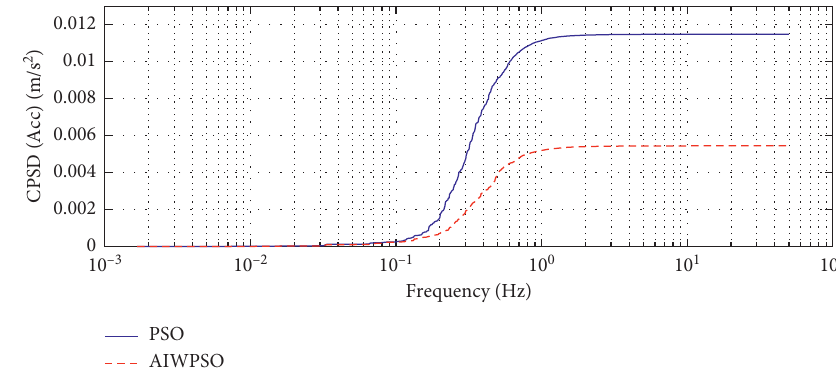
Figure 23: CPSD of acceleration for a bumpy road profile.